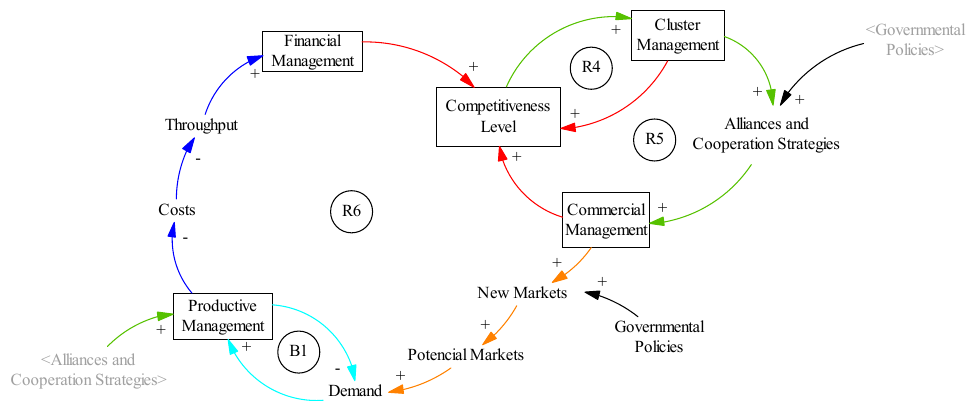
Figure 6. Cycles R4, R5, R6, and B1. Commercial Management, Productive Management, Cluster Management, and Competitiveness Level.